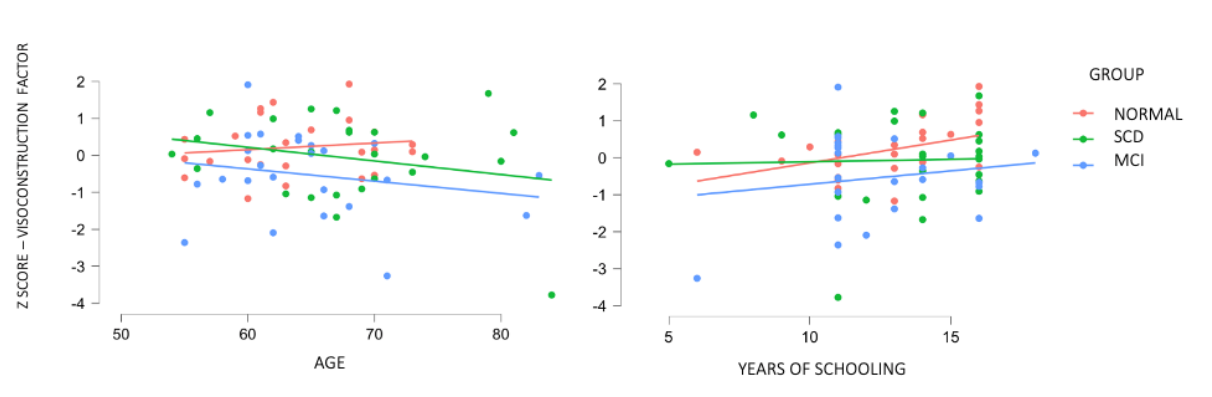
Figure 2. Descriptive plots of visoconstructional factor in pre-clinical groups by age and years of